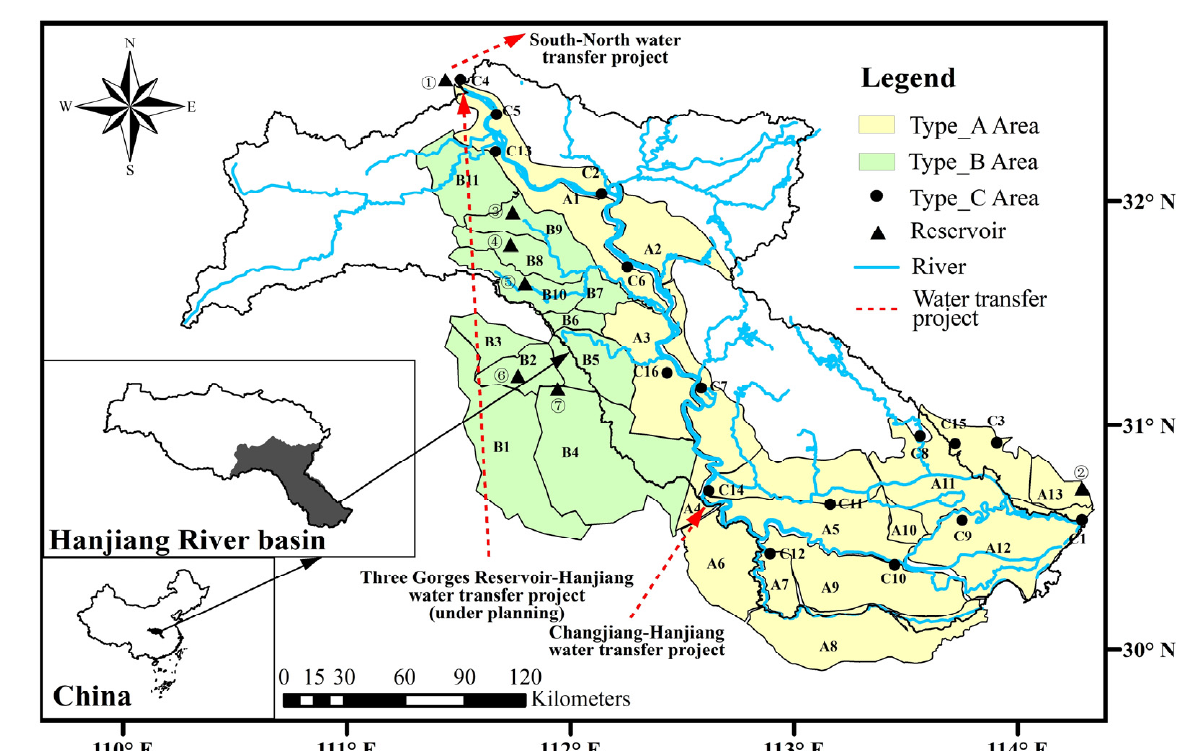
Figure 2. Location of the mid-lower reaches of the Hanjiang River basin, China.